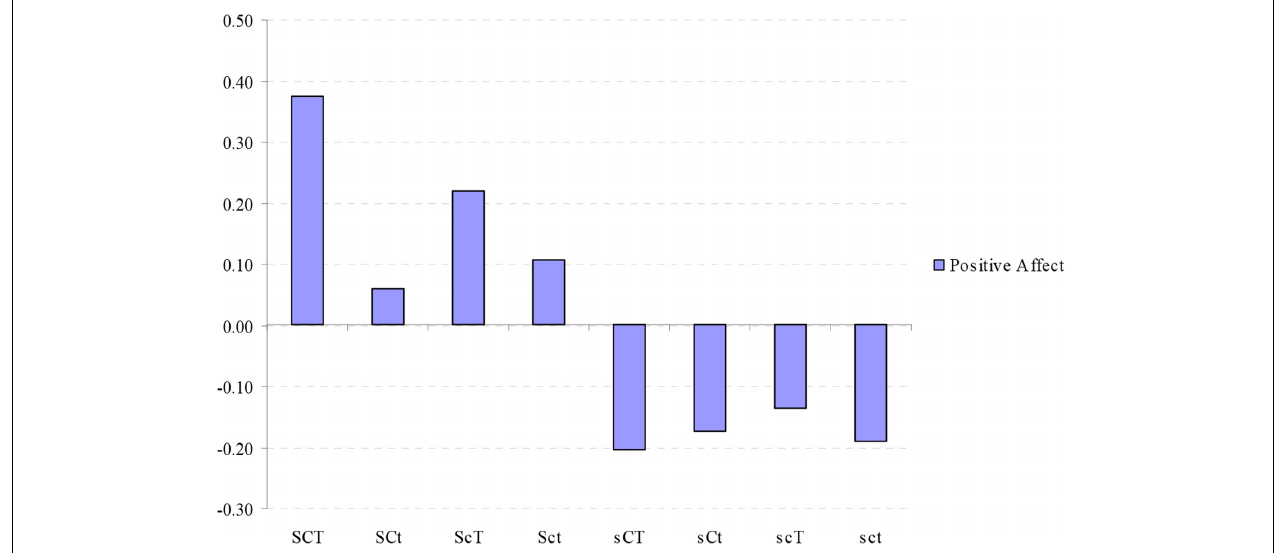
FIGURE 1 | Standardized values (mean = 0, SD = 1) of positive affect in different character combinations. SCT, creative; SCt, Organized; ScT, Fanatical; Sct, Autocratic; sCT, Moody; sCt, Dependent; scT, Disorganized; sct, Depressive; ANOVA: F = 15.89, p = 0 . 00.